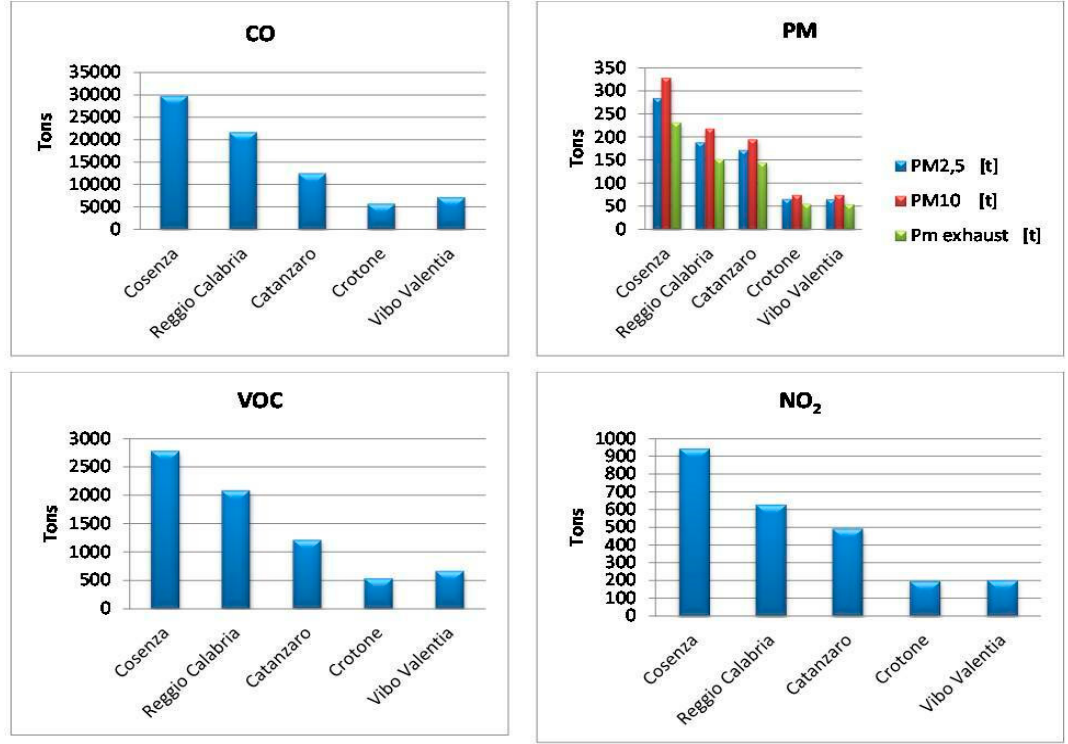
Figure 3. Total emissions produced, expressed in tons, in 2015, in the five provinces of Calabria.